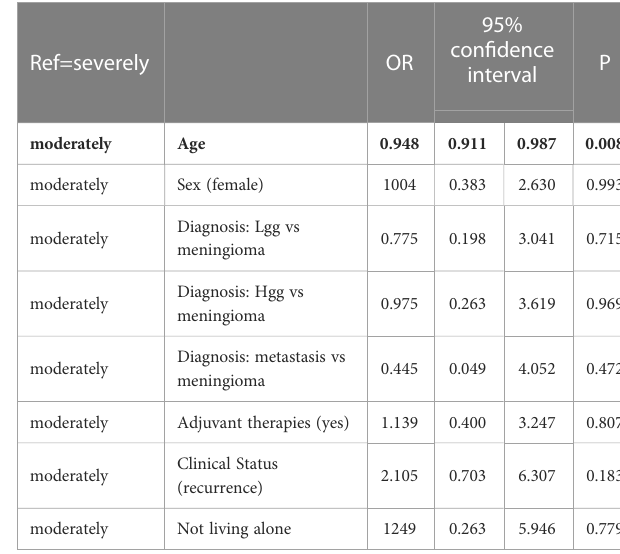
TABLE 3 – Variables associated with Sense of Loneliness- Results of multinomial regression analysis.